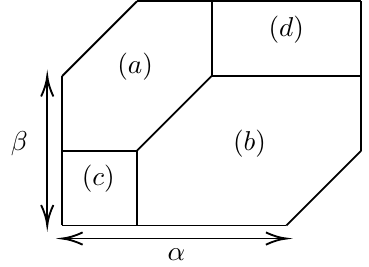
Figure 5 . An example of TCMD for diagonal quiver with m = 2: the Minkowski sum Q = Q 0 + Q 1 + Q 2 is decomposed into the 4 non-overlapping